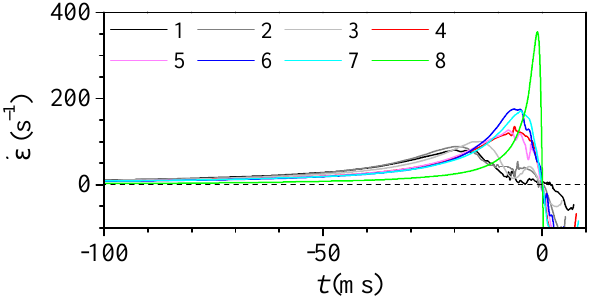
Figure 7. Strain rate along the nozzle axis versus the time to cross the neck for Q = 5 µ L/min. The colour indicates the nozzle number in Table 1.